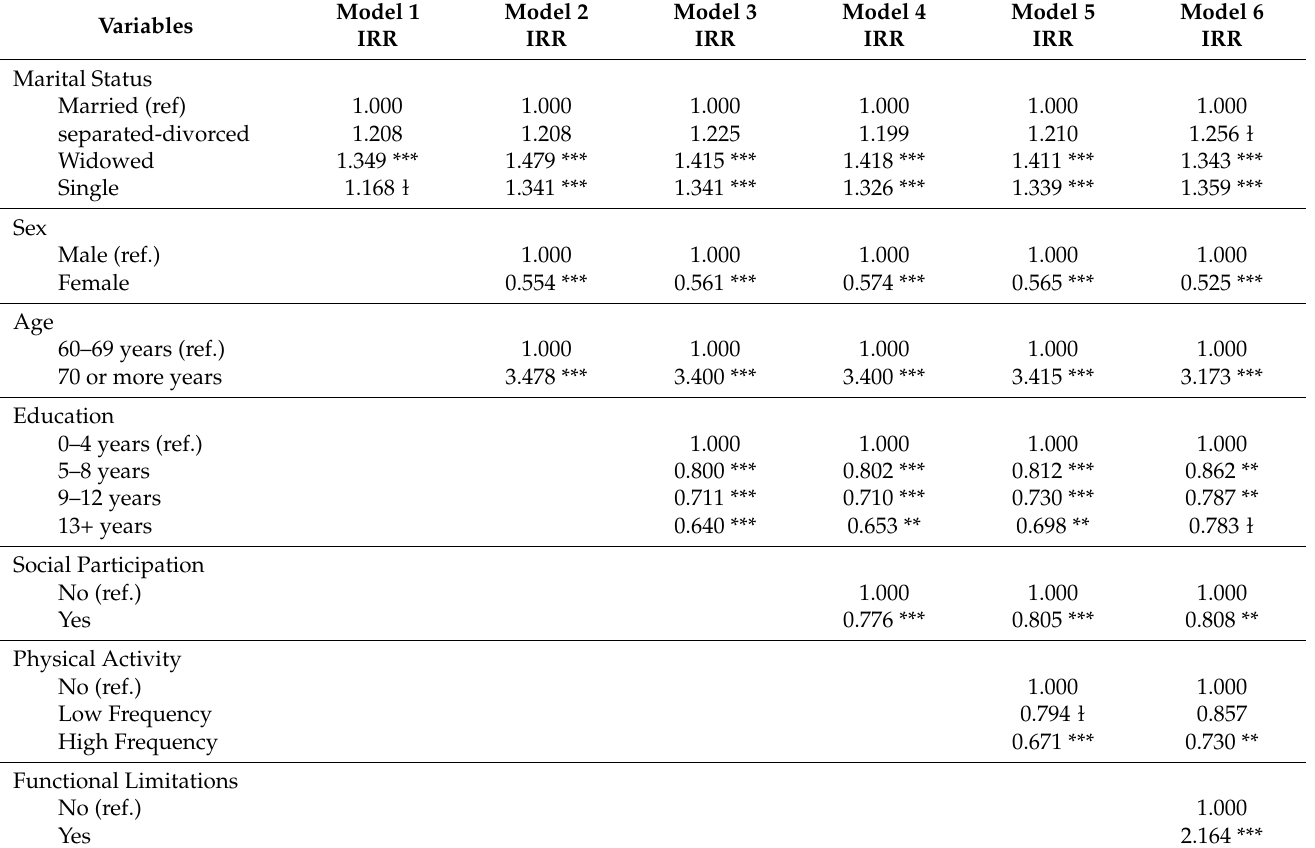
Table 2. Rate ratios for the association between marital status and mortality in older adults,